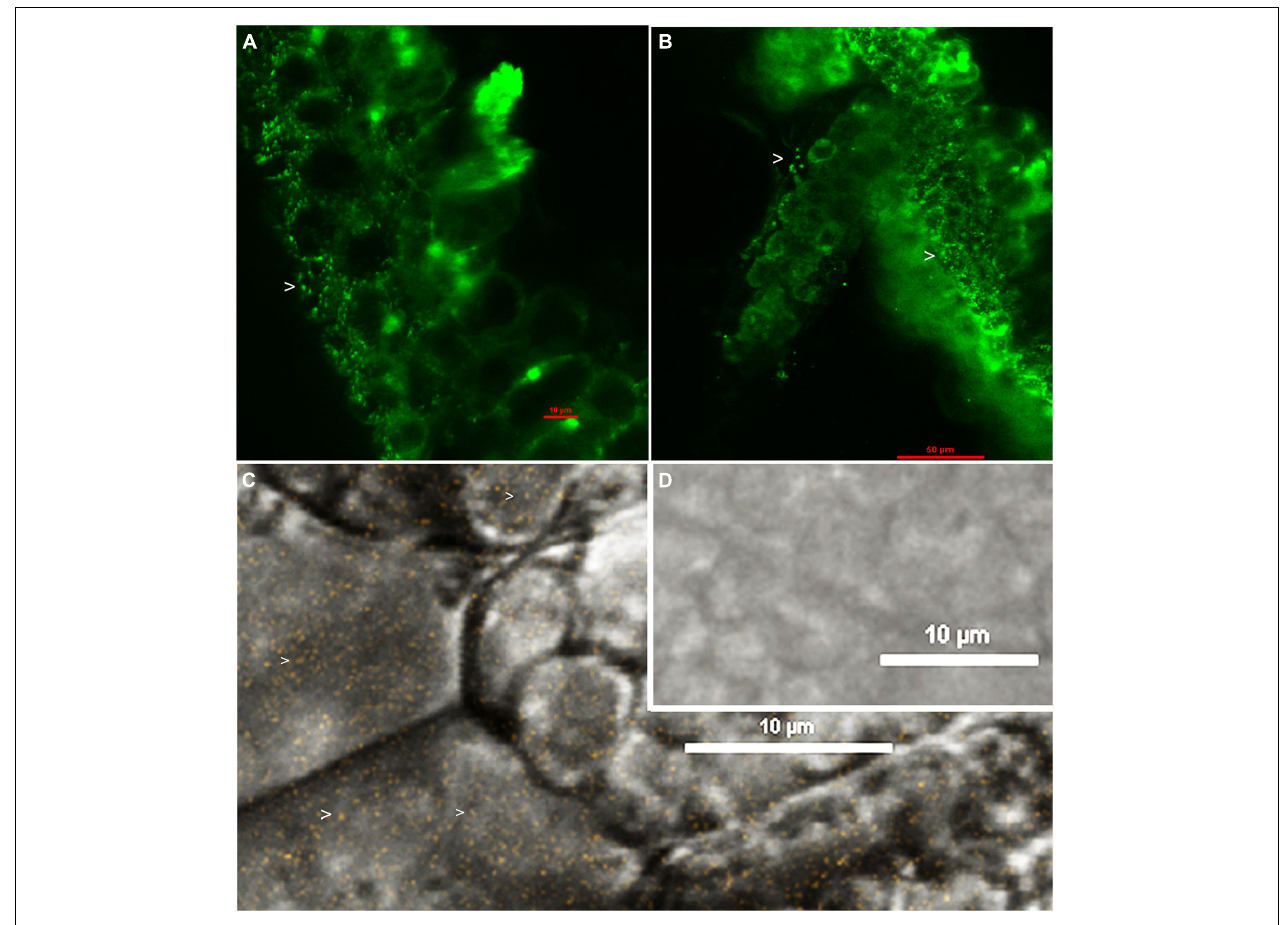
FIGURE 2 | Confocal imaging after SYTO-9 staining, or FISH with Eub338 probe on seed tissue sections of watermelon “Arka Manik”: Perisperm tissue stained with SYTO-9 under 488 nm green channel (A) , seed embryo stained with SYTO-9 under 488 nm green channel (B) , FISH on seed embryo tissues of watermelon with Cy3 labeled Eub338 displaying abundant fluorescing bacteria under 543.5 nm channel (C) , and FISH negative control with Eub338ns (D) . Arrow heads show bacterial